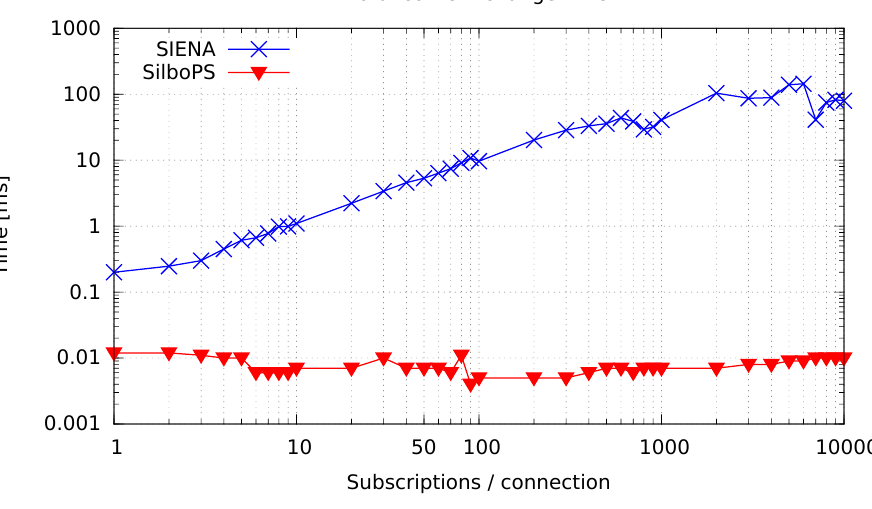
Figure 9. Time for a single context change with an increasing number of subscription per